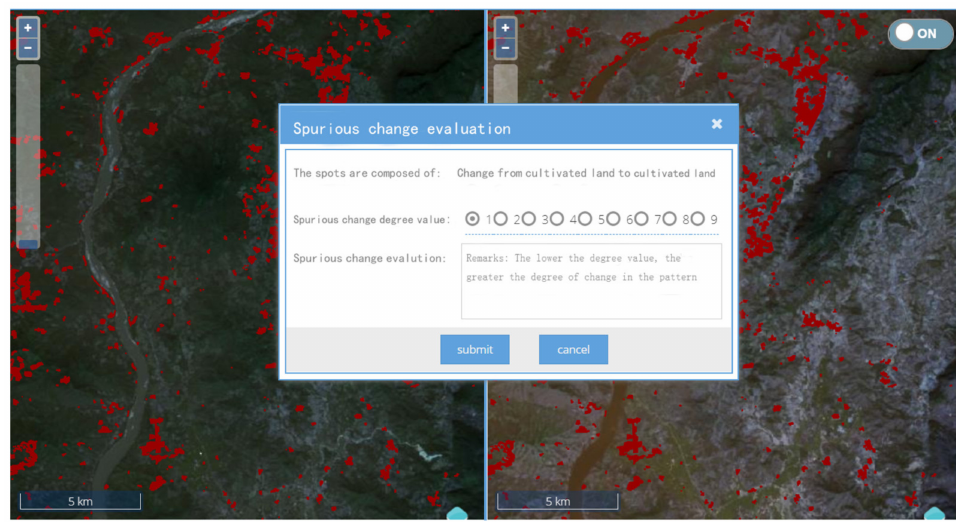
Figure 8. Acquisition interface of the online platform for the spurious change degree values of the changed